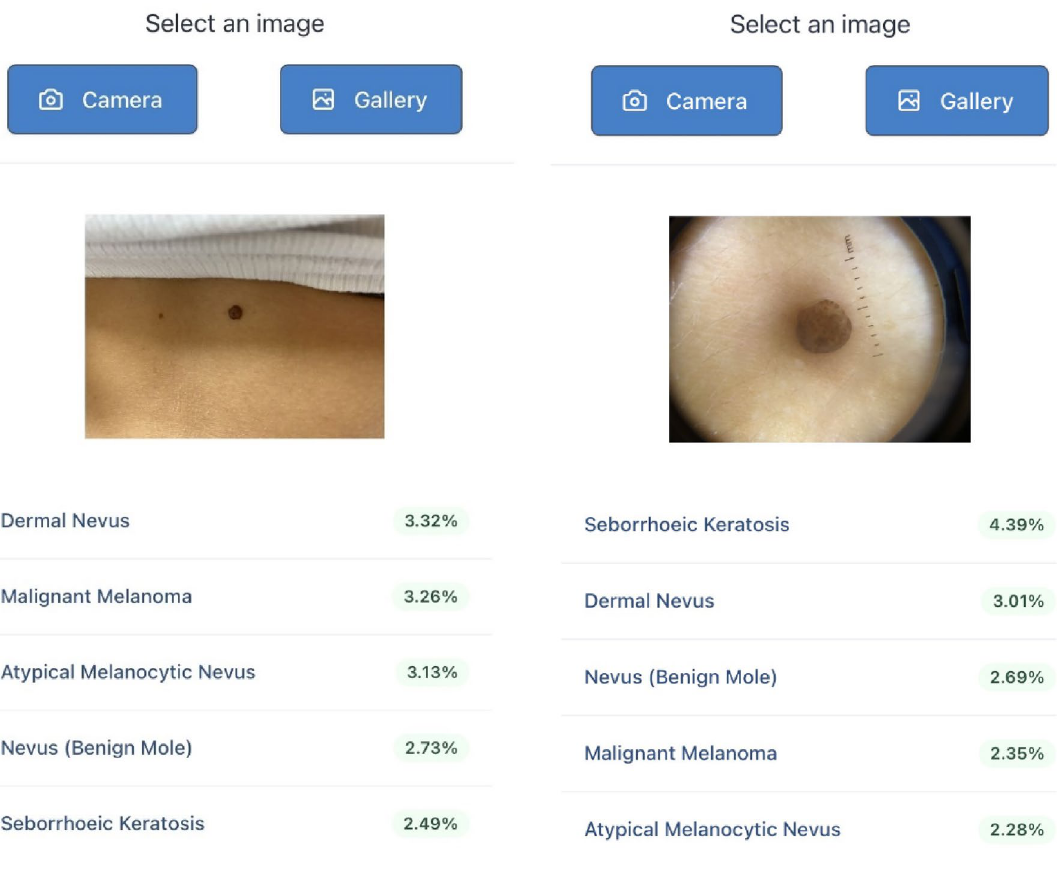
Figure 3. Autoderm